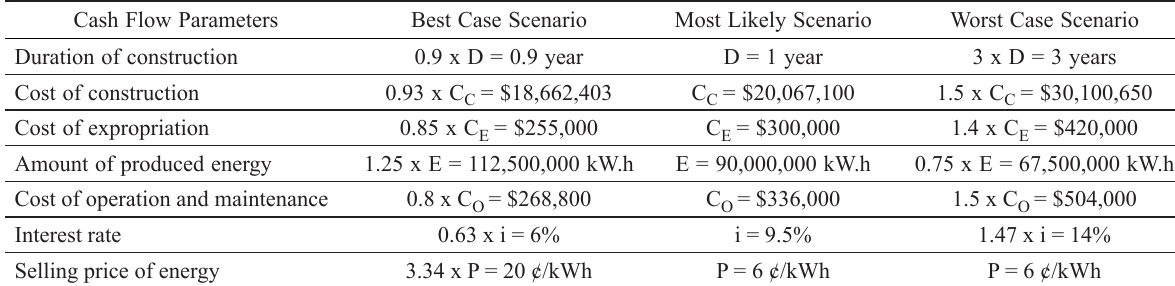
Table 4. Probability distributions for cash flow elements for case